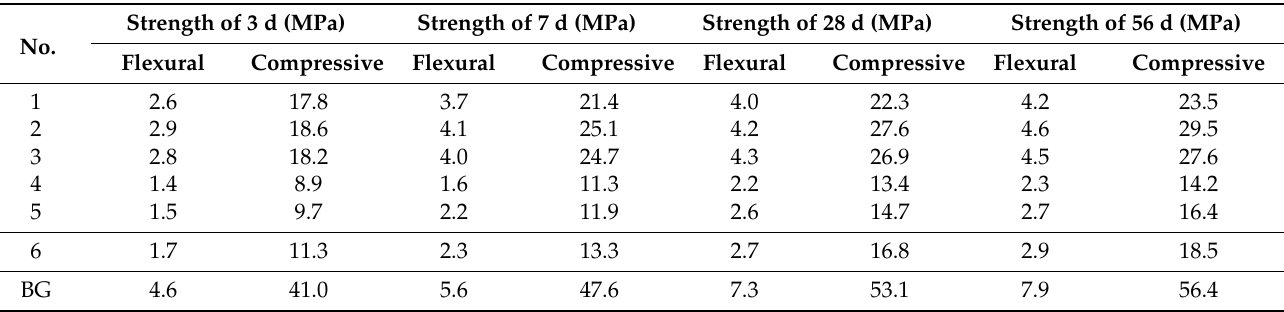
Table 6. Strength of test blocks at various ages.